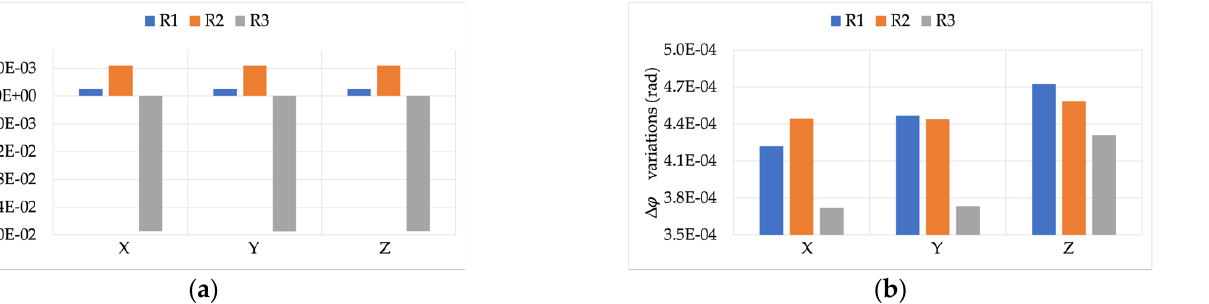
Figure 11. 𝜀 and ∆𝜑 variations (( a , b ), respectively), compared to position L, for the three signals measured with position N.